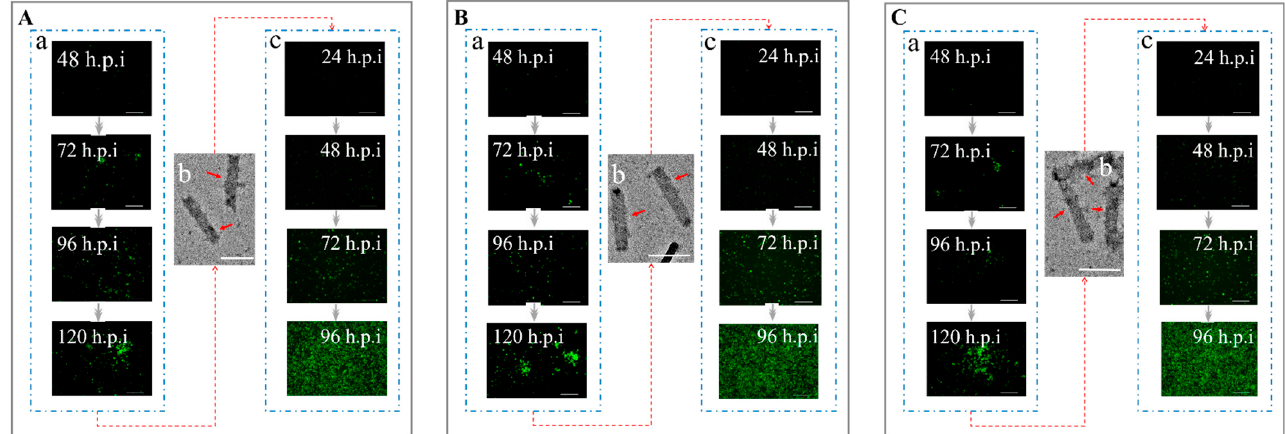
Figure 6. Construction of AcBVs carrying vsvg and invasin . ( A ) Construction of recombinant AcBV-